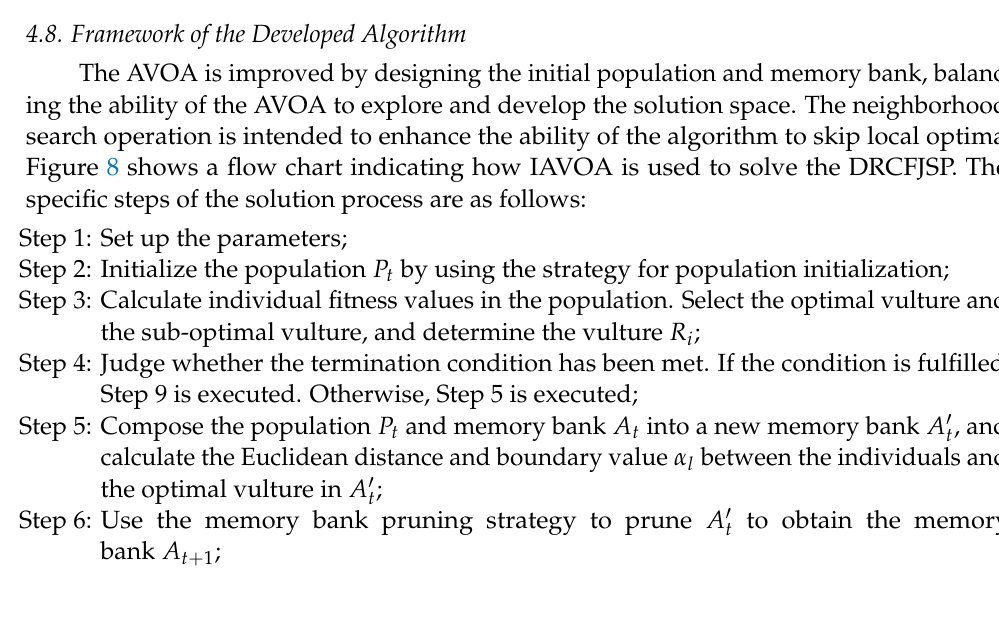
Figure 7. Operation flow of the neighborhood search operation.